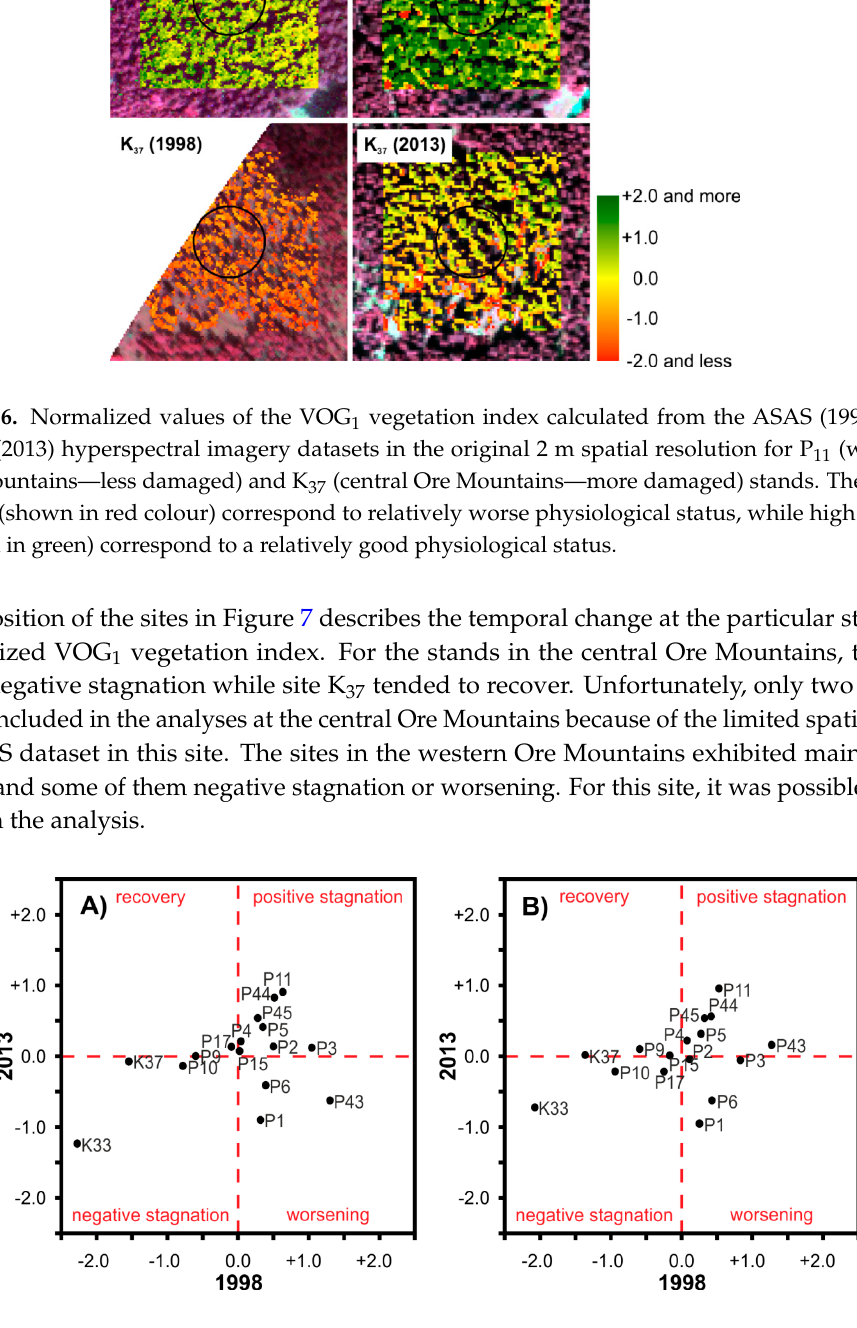
Figure 7. Visualization of Norway spruce health status temporal change using normalized VOG 1 vegetation index constructed for original ( A ) and generalized ( B ) spatial resolution of the used image data. P—western Ore Mountains (Pˇrebuz) sites, and K—central Ore Mountains (Kováˇrská)